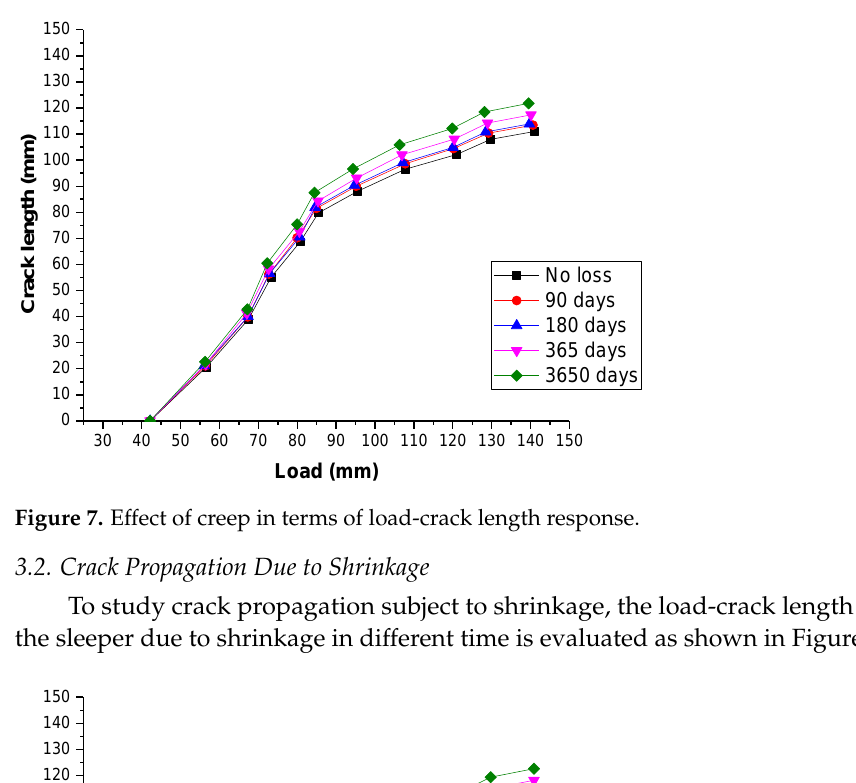
Figure 7. Effect of creep in terms of load-crack length response.